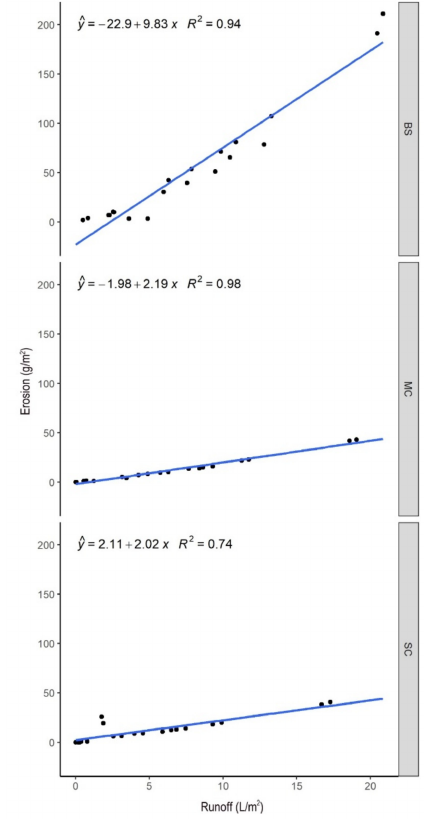
Figure 5. Relationship between erosion rate (g / m 2 ) and runo ff (L / m 2 ) by soil cover types (BS: bare soil, MC: metal sieve cover, and SC: strip